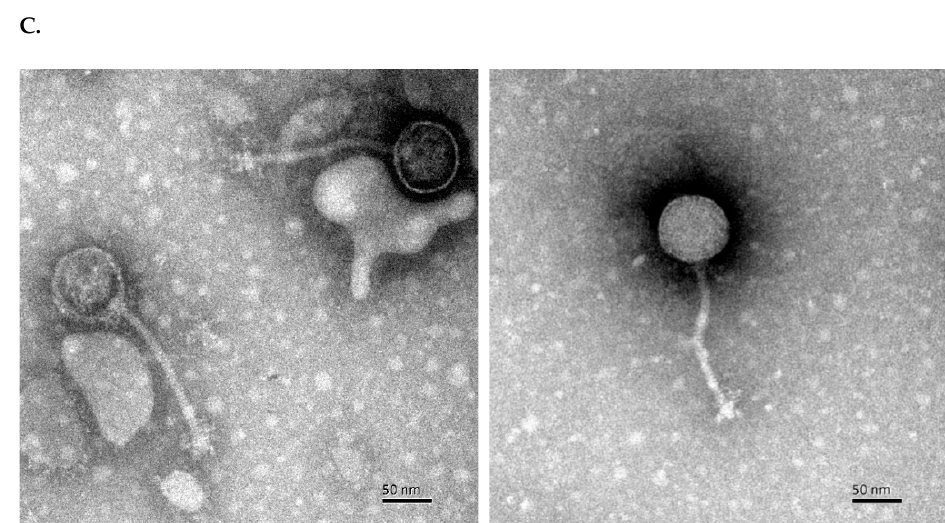
Figure 1. Characterization of the C. perfringens phage BG3P . ( A ) Phage lysis plaques on the host ( C. perfringens BG3) lawn. ( B ) Phage plaque on the host lawn. ( C ) Electron microscopy image of phage BG3P particles. The sample was viewed at a magnification of 200,000×; Scale bar represents 50 nm.